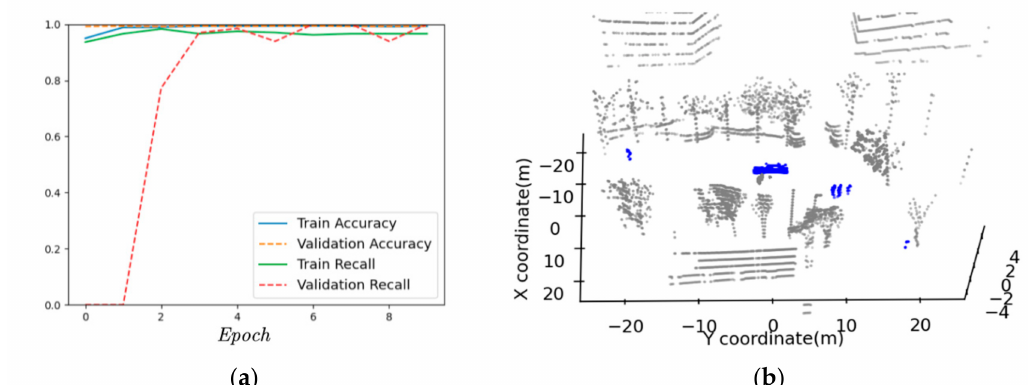
Figure 16. The results of model training and prediction. ( a ) Overall accuracy and recall of labeling road users by the proposed model; ( b ) The results of labeling road users in the point cloud, where blue objects are road users and gray objects are static